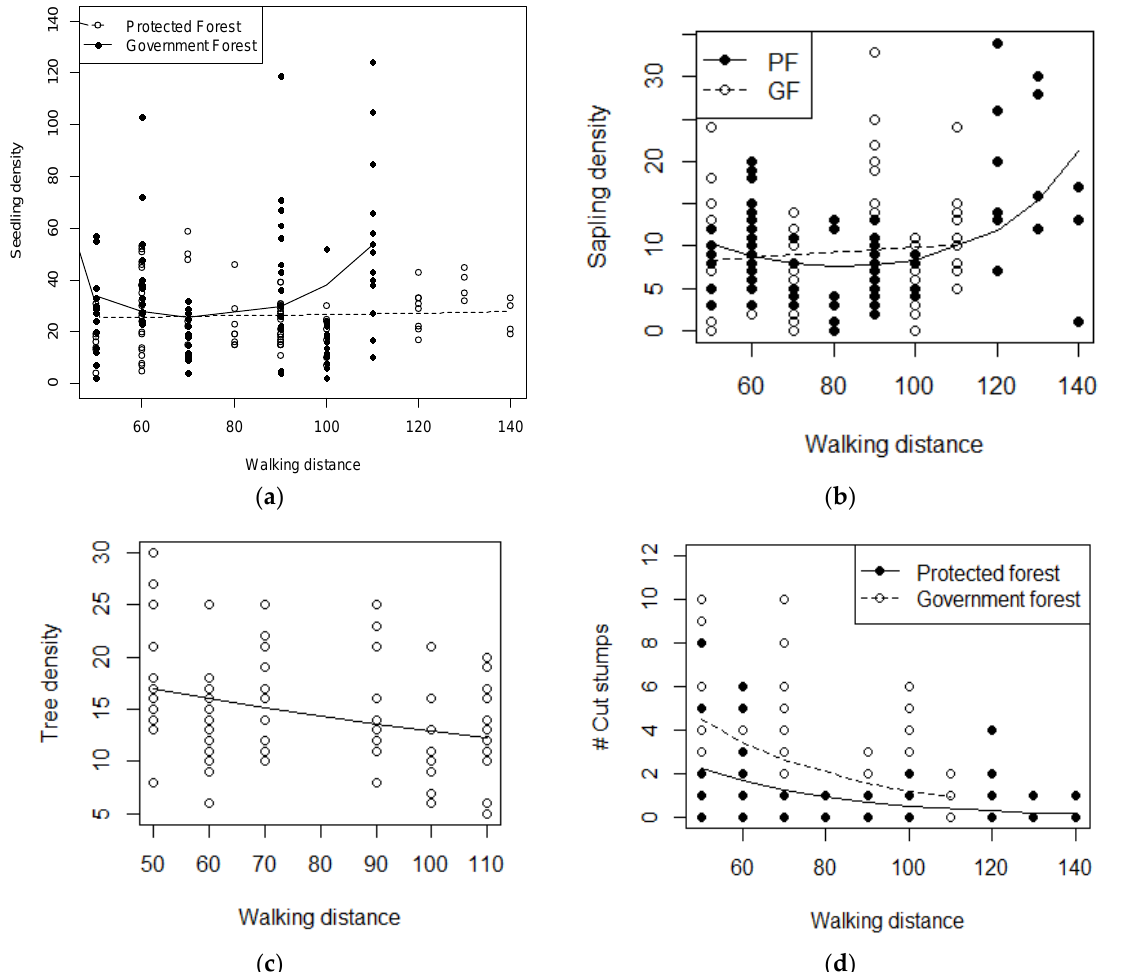
Figure 4. The relationship between walking distance (in minutes) from closest settlement and ( a ) seedling density in protected forests (PF) and government forests (GF), ( b ) sapling density in protected forests and government forests, ( c ) tree density in government forests, and ( d ) the number of cut stumps in protected forests and government forests. # = number of. Table 3. Comparison of means (median) of regeneration and disturbance parameters between two sampled elevations in protected forests (PF) and in government forests (GF) in the Langtang area of Nepal, tested by a Mann-Whitney U -test.